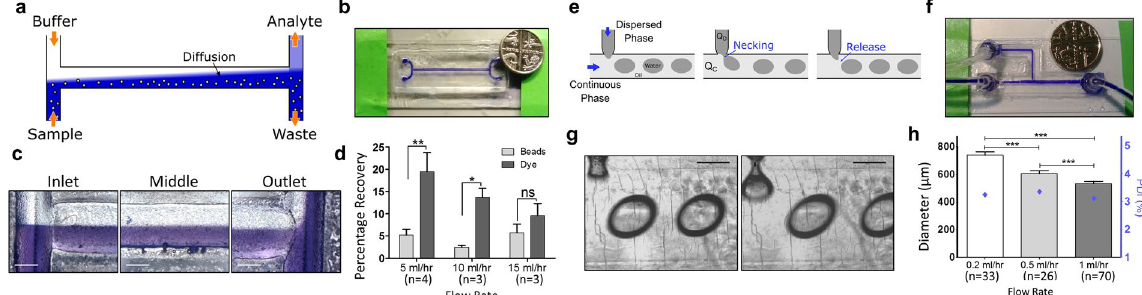
Figure 7. Example microfluidic devices. ( a ) Schematic of the operation of an H-filter. Diffusion dominates mass exchange between parallel streams, enabling size fractioning via flow splitting. ( b ) PMMA microfluidic H-filter fabricated by laser ablation and capillarity-assisted adhesive bonding. Coin (5 pence) for comparison. ( c ) Operation of the PMMA H-filter under laminar flow. The bottom stream (sample inlet) contains a blue dye and 20 µ m polystyrene beads. The sample and buffer streams remain parallel and split at the outlet, with a fraction of the dye that has diffused to the buffer stream exiting through the analyte outlet. Scale bar: 500 μ m. ( d ) Percentage of the dye and beads contents recovered at the analyte outlet of the H filter at different flow rates (5, 10 and 15 ml hr − 1 ). Data analysed by two-way mixed ANOVA ( * p < 0.05, ** p < 0.01 and ns non-significant) with Bonferroni post-test and shown as mean ± s.e.m. ( e ) Schematic of the droplet generation process in the T-junction. The interaction between the two immiscible phases causes necking and pinching of the dispersed phase and release into the main channel. ( f ) PMMA T-junction droplet generator with glued tubing. Coin (5 pence) for comparison. ( g ) Formation and necking of a water-in-oil droplet at the T junction via dripping regime. Scale bar: 500 µ m. ( h ) Mean droplet diameter and polydispersity index (PDI) for the droplets produced in the T-junction droplet generator at different flow rates: 0.2, 0.5 and 1 ml hr − 1 (flow rate ratio between continuous and disperse phases Q C /Q D = 1.63 in all cases). Droplet diameter data analysed by one-way ANOVA ( *** p < 0.001) with Tukey post-hoc test, and shown as mean ±